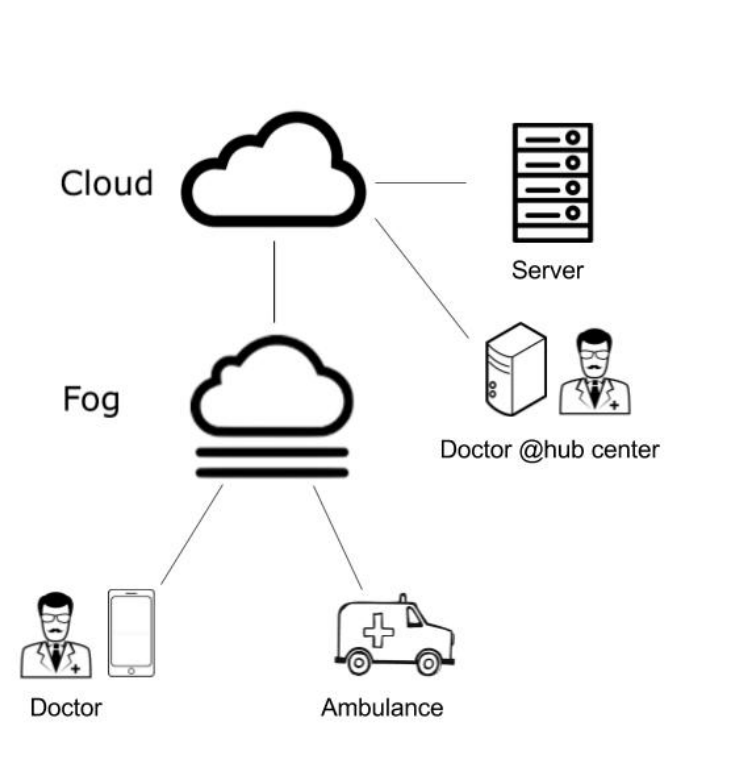
Figure 1. System